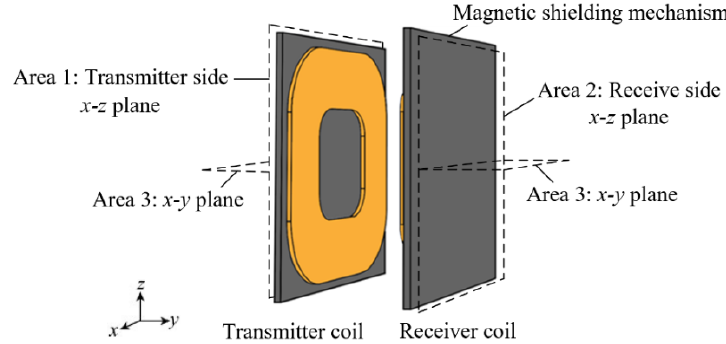
Table 1. Main parameters of the coupling mechanism simulation model.